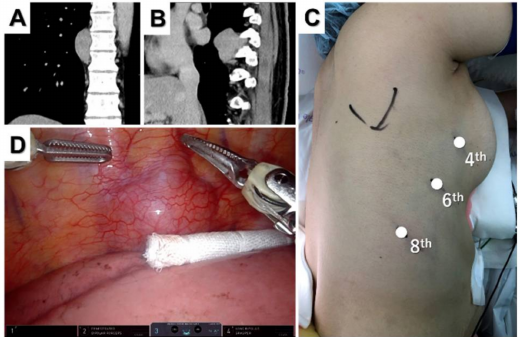
Figure 3. Posterior mediastinal tumor. Coronal ( A ) and sagittal ( B ) computed tomography views of the tumor located at the Th8–9 level. Port placement for three-arm robotic resection of a